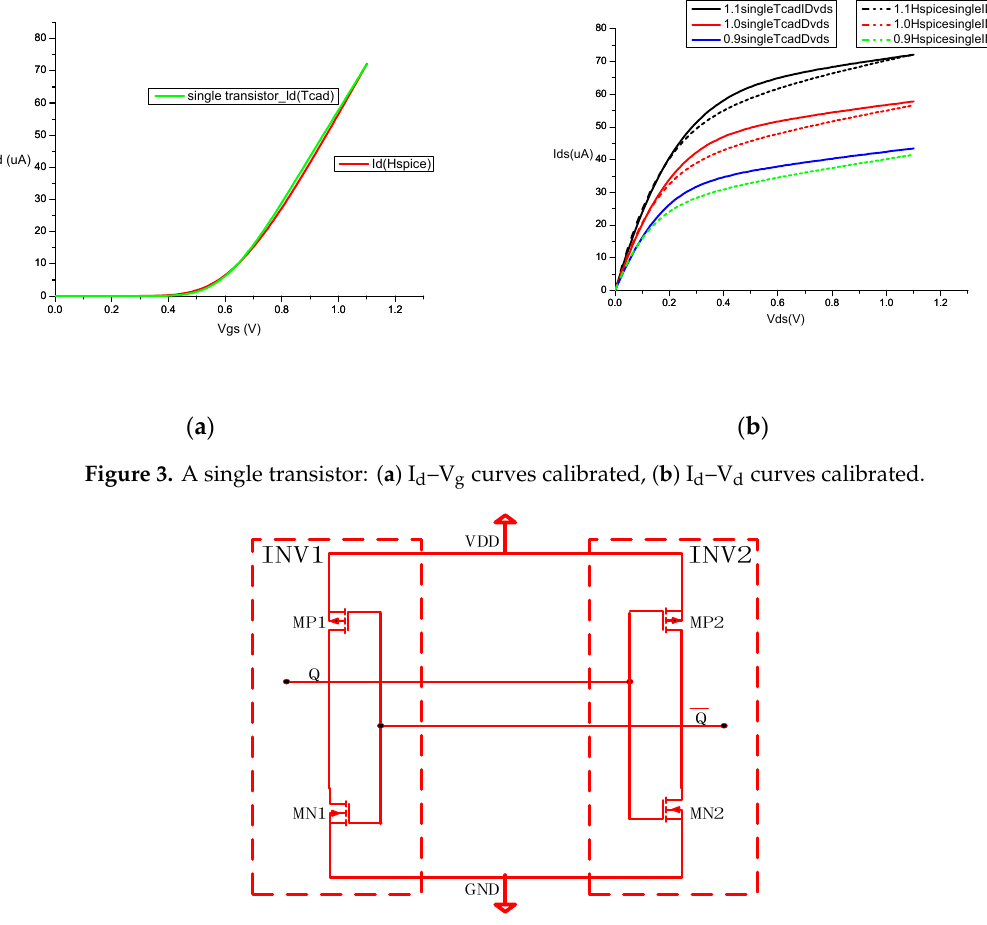
Figure 4. The main circuit structure of a SRAM cell.